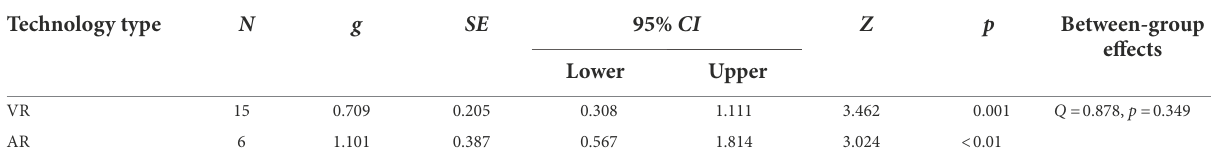
TABLE 4 Impacts of XR on the learning effects, by technology